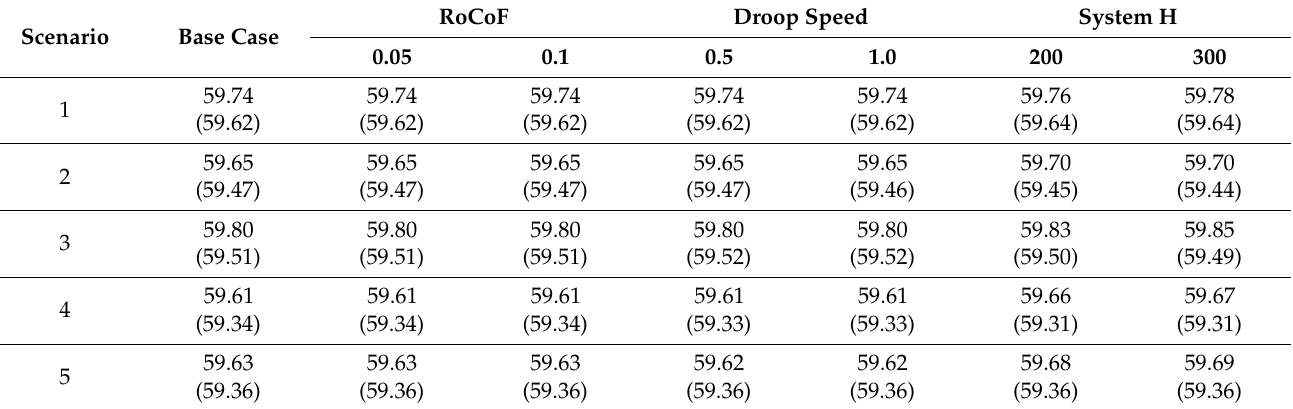
Table 14. Lowest frequency per parameter (RoCoF control) (Hz): three-phase short